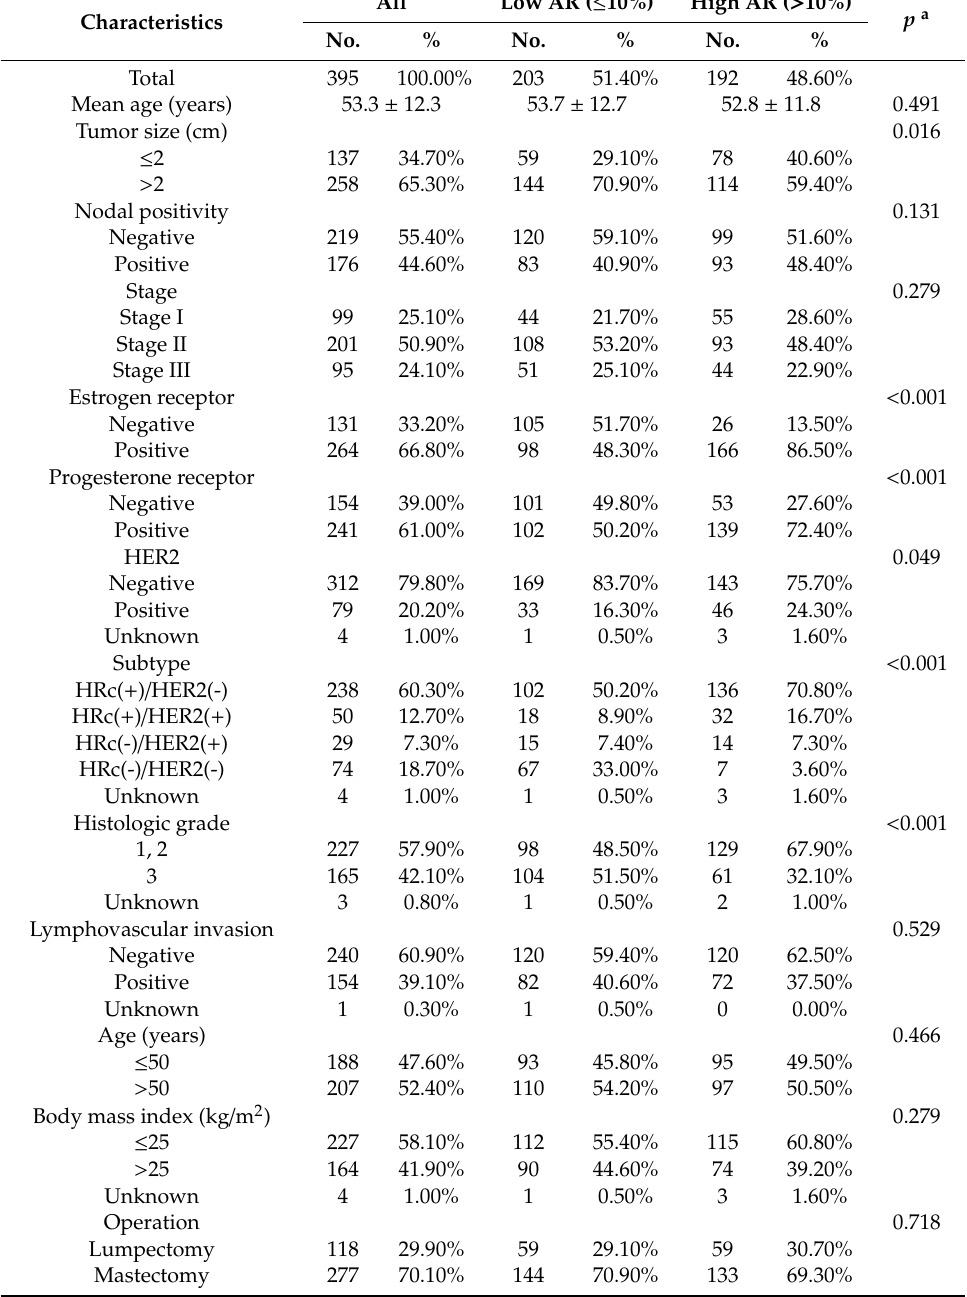
Table 1. Baseline characteristics of study subjects according to proportion score with the cut-o ff value of 10% by immunohistochemistry regarding